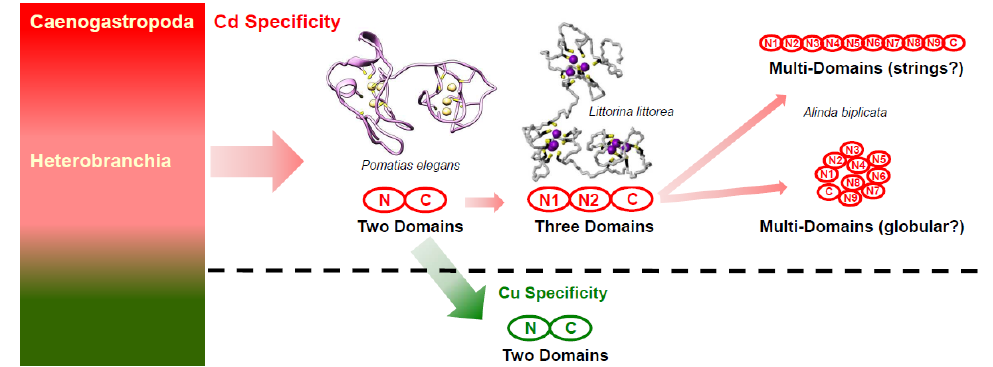
Figure 8. Hypothesis of evolution of metal-specificity and structure in MTs of the two gastropod clades Heterobranchia and Caenogastropoda (left-hand, multi-colored box). Two-domain or multi-domain Cd-specific MTs (CdMTs) in Caneogastropoda and Heterobranchia are shadowed in pink. Two-domain Cu-specific MTs (CuMTs) in some lineages of Heterobranchia are shadowed in green. Adapted from Dallinger 2018 [86].